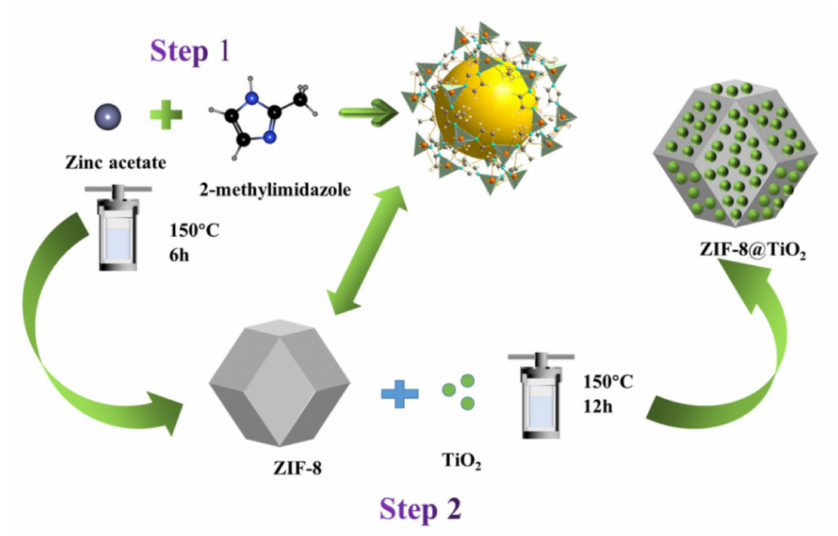
Figure 1. Synthesis process of ZIF-8@TiO 2 composite, step 1 is the preparation process of ZIF-8, step 2 is the preparation process of ZIF-8@TiO 2